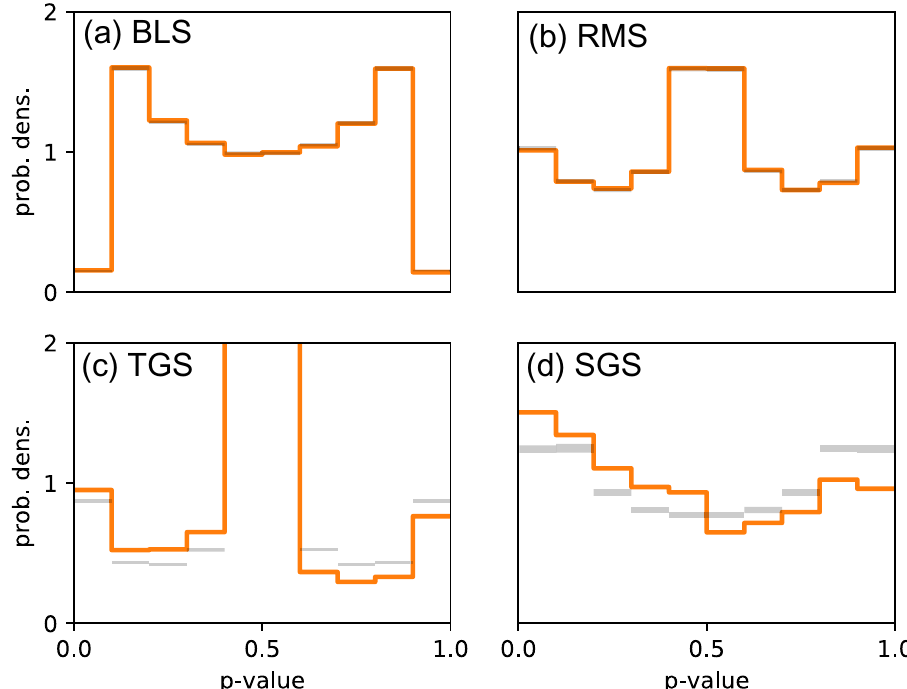
Figure 2. Application of the p value method to four different types of simulated data. Shown are in each case the p value distributions q obs ( ˆ p ) of the actual system (orange lines) and the confidence intervals (gray shaded areas), based on the distributions q ref ( ˆ p ) of the randomized reference systems. Values above (or below) the confidence interval occur with a probability of 5% in the randomized system. ( a ) Blind search (BLS): Simulated immune cells migrate blindly, according to a correlated random walk with temporally constant migration parameters. ( b ) Random mode switching (RMS): Simulated immune cells migrate blindly, according to a correlated random walk with temporally fluctuating migration parameters. ( c ) Temporal gradient sensing (TGS): Simulated immune cells use temporal gradients of a chemo-attractant to pursue the target cells. ( d ) Spatial gradient sensing (SGS): Simulated immune cells use spatial gradients of a chemo-attractant to pursue the target cells. In cases ( a ) and ( b ), where there are no interactions between simulated immune and target cells, the actual p value distributions are inside the confidence intervals of the randomized system. In cases ( c ) and ( d ), chemotactic interactions between simulated immune and target cells lead to significant differences between the observed and reference